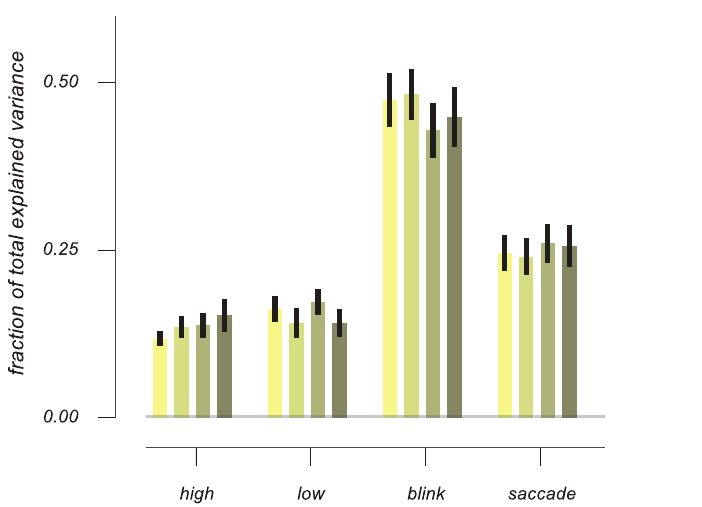
Fig 4. Fraction of total explained variance for each of the response profiles. Ocular event response profiles together explain almost four times more variance in the signal than auditory events combined. Colours represent the different conditions in the following order; 1. known timing, known identity, 2. known timing, unknown identity, 3. unknown timing, known identity, 4. unknown timing, unknown identity. Error bars are +/- 1 standard error of the mean across